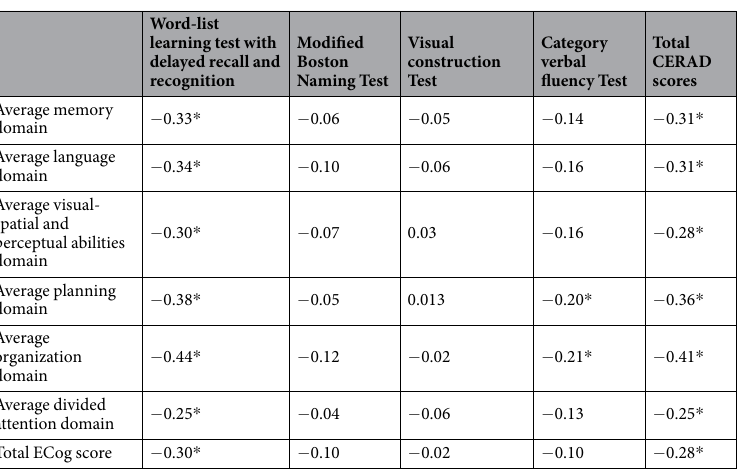
Table 3. Pairwise correlation between four domains of CERAD-NAB score and six domains of the ECog score in all participants. Abbreviations: ECog, Everyday Cognition; CERAD-NAB, Consortium to Establish a Registry for Alzheimer’s Disease Neuropsychological Assessment Battery Tested by spearman’s rank correlation. * P <